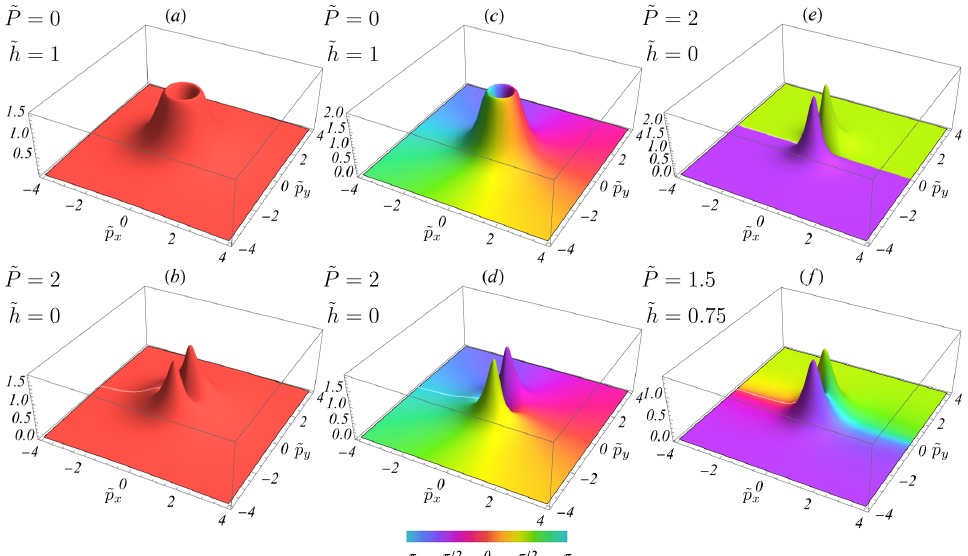
Figure 8: Orbital wave functions of the two-fermion bound state formed in the pres- ) represen- ence of 2D-Dirac spin-orbit coupling in relative-momentum p ≡ ( p , p x y tation. Surface height and color scale depict amplitude and phase, respectively, for 〈 S M | ψ ( p ) 〉 / N ≡ 〈 S M | ˆ G ( E ≡ p / ( m λ ) . Panels (a) , p ) | 00 〉 as a function of ˜ p j j P P b b and (b) show the singlet component ( S = 0, M = 0) and panels (c) and (d) the spin- polarized triplet component ( S = 1, M = − 1), which is dominant for P = 0 , ˜ h ≈ 1 and weak s -wave interaction strength. Panels (e) and (f) show the spin-unpolarized triplet component ( S = 1, M = 0), which occurs only for finite P . The dimensionless = 0.2, and values for the dimensionless Zeeman energy ˜ h interaction strength is ˜ ε 0 and COM momentum P / ( m λ ) = ( ˜ P ,0 ) are indicated in each